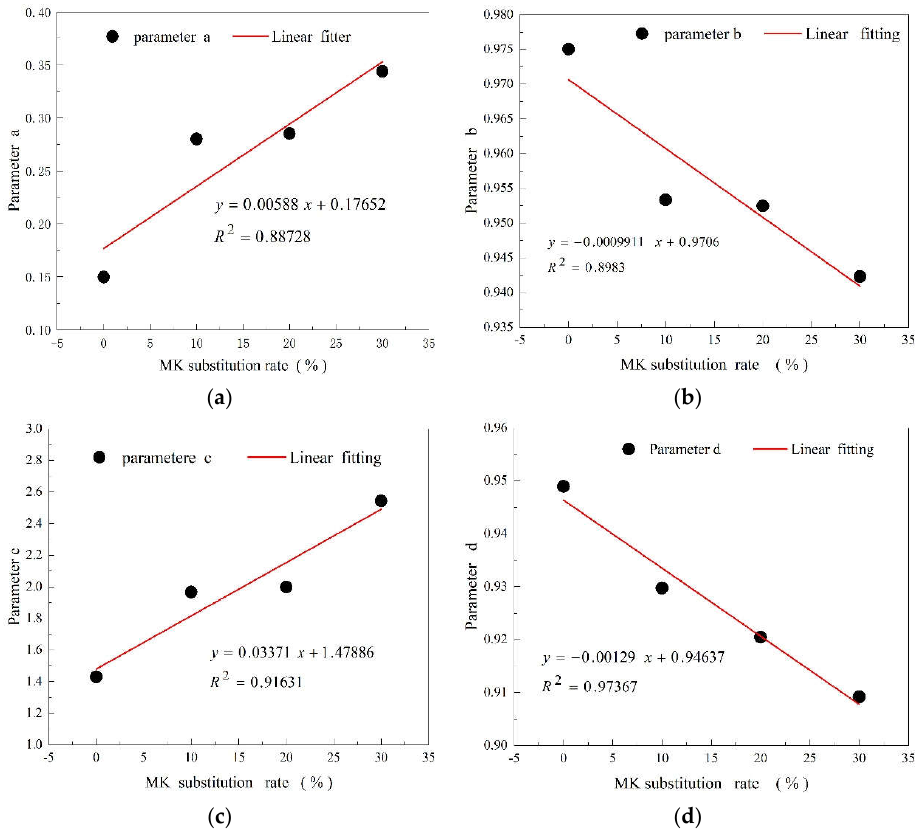
Figure 4. Relation among coefficients ( a – d ) and replacement rate of MK.